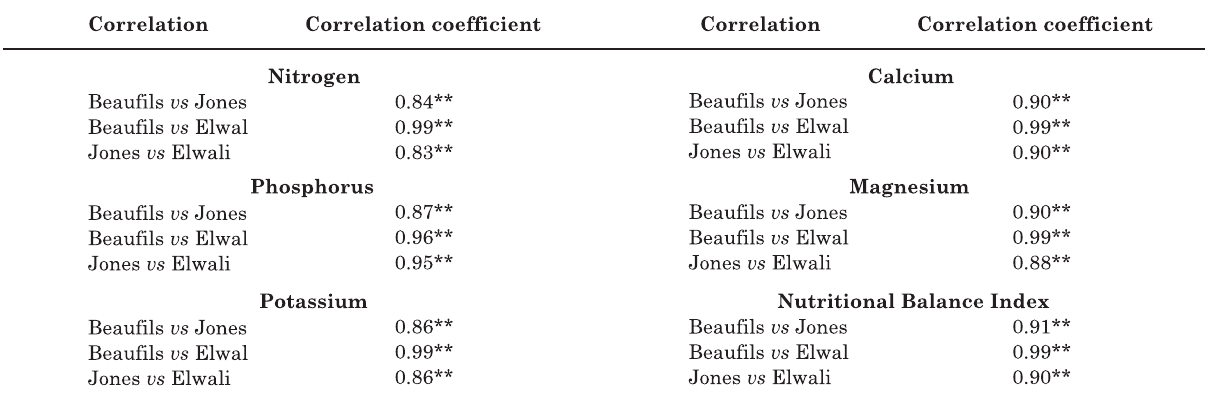
**: Significant at 1 % by the T Test